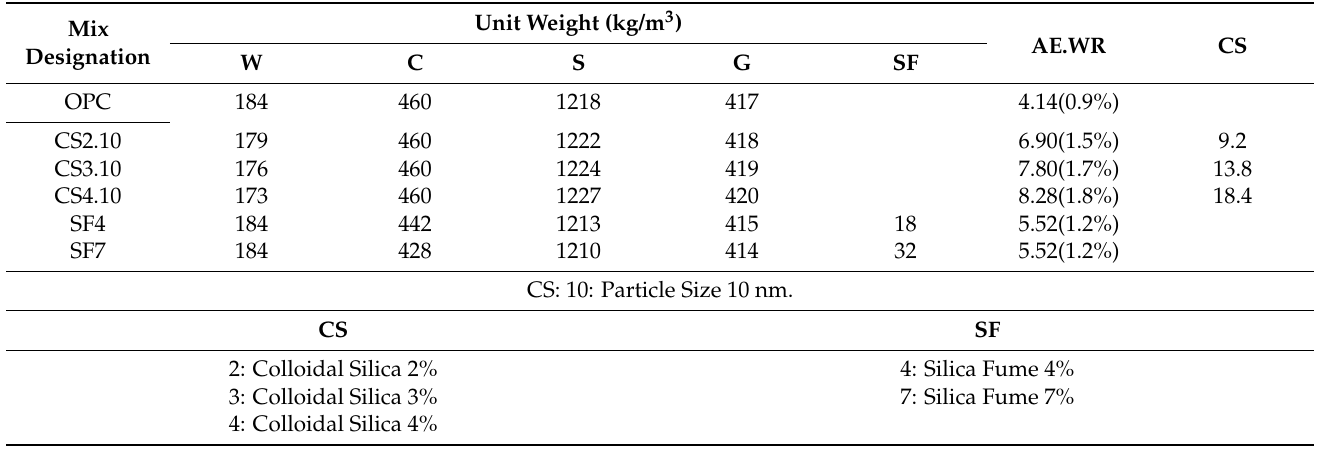
Table 2. Shotcrete